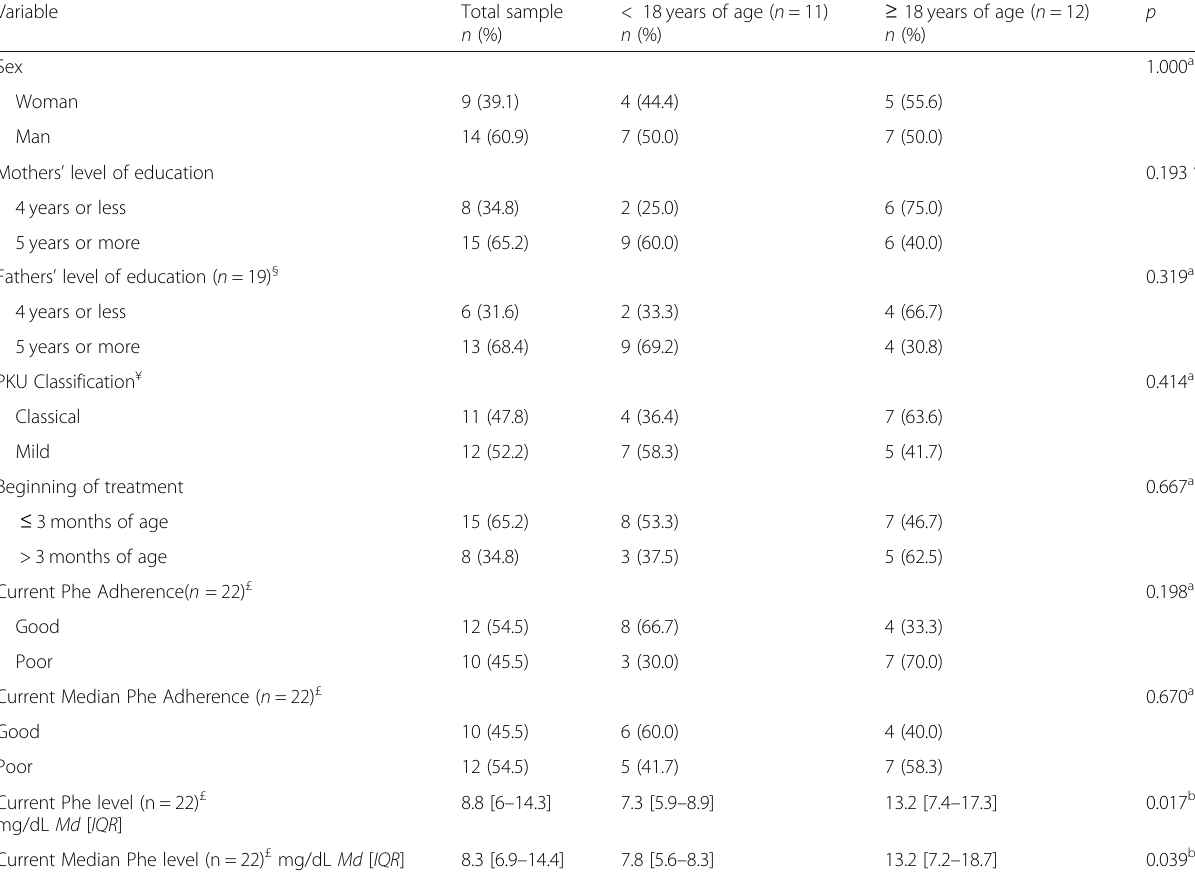
Table 3 Demographics characteristics of patients with Phenylketonuria in the study, according to age group